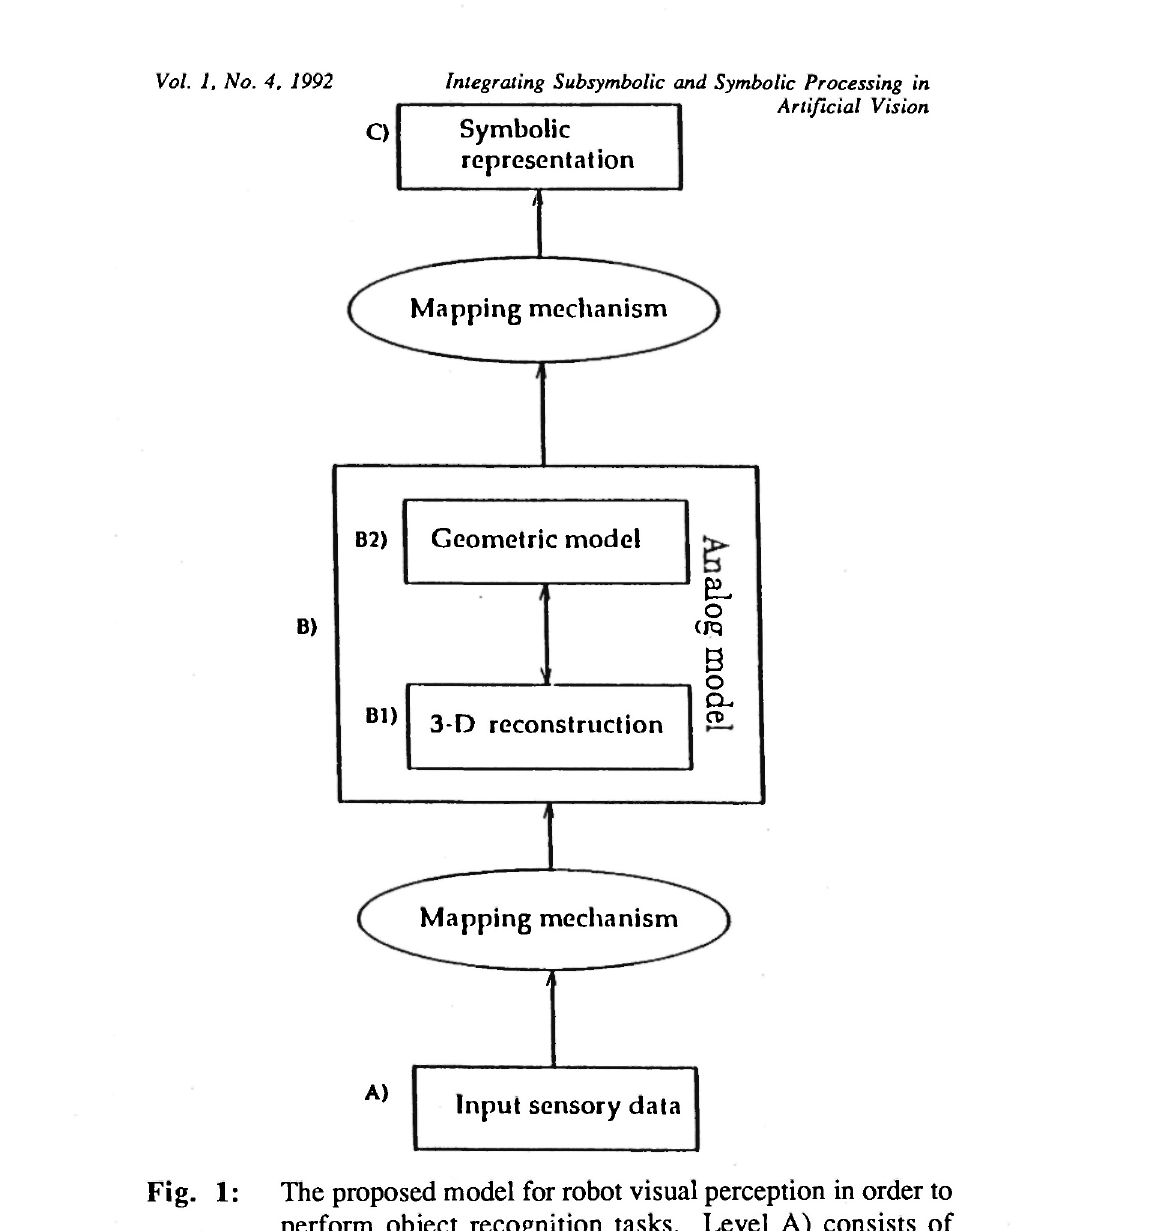
Fig. 1: The proposed model for robot visual perception in order to perform object recognition tasks. Level A) consists of input data from sensors connected to the external world. Level B) consists of the analog representation of the per- ceived scene. (Bl) consists in a 3-D volumetric reconstruc- tion of the observed scene. (B2) is the representation of the reconstructed scene in terms of a geometric model. Level C) is a symbolic representation of the domain considered.